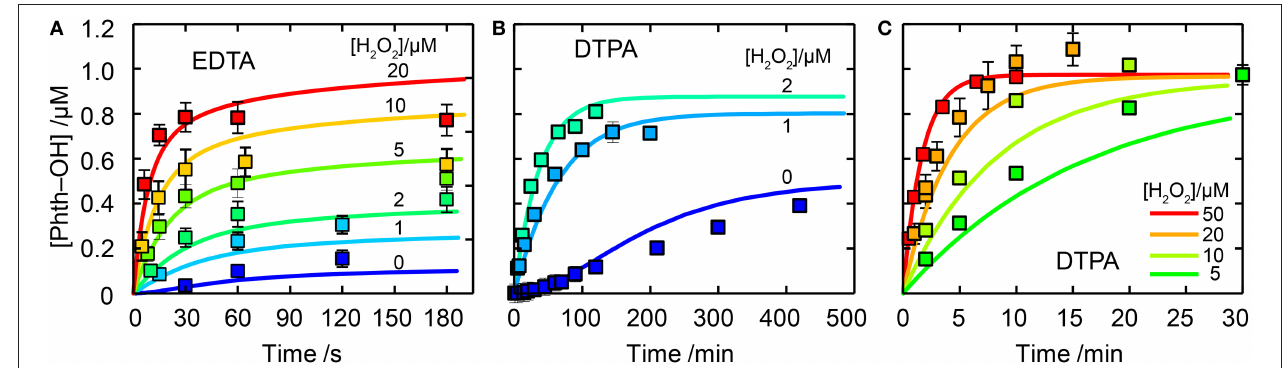
FIGURE 3 | Phth-OH production by Fe(II)EDTA (A) and Fe(II)DTPA (B,C). Experimental data are shown as symbols with error bars the standard deviation of three replicate experiments. Kinetic model results are shown as solid lines (with k 10 = 6 × 10 4 M − 1 s − 1 for EDTA). In all cases [Fe(II)] = 2 µ M, [L] = 10 µ M and [H 2 O 2 ] is as labeled.